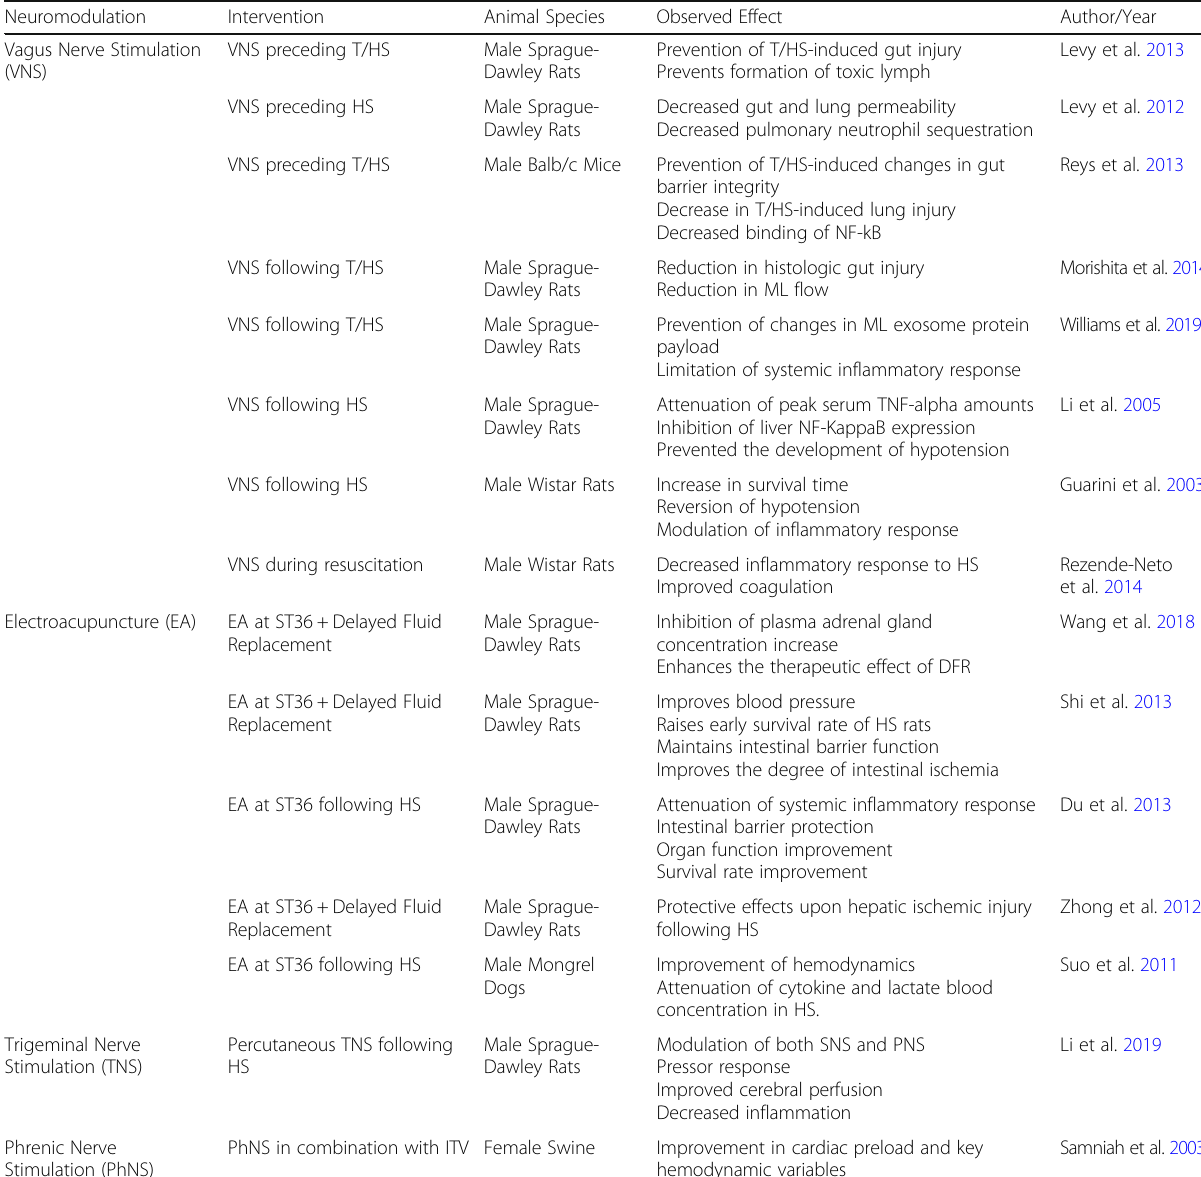
Table 1 Novel Neuromodulation Methods of Hemorrhagic Shock Neuromodulation Intervention Animal